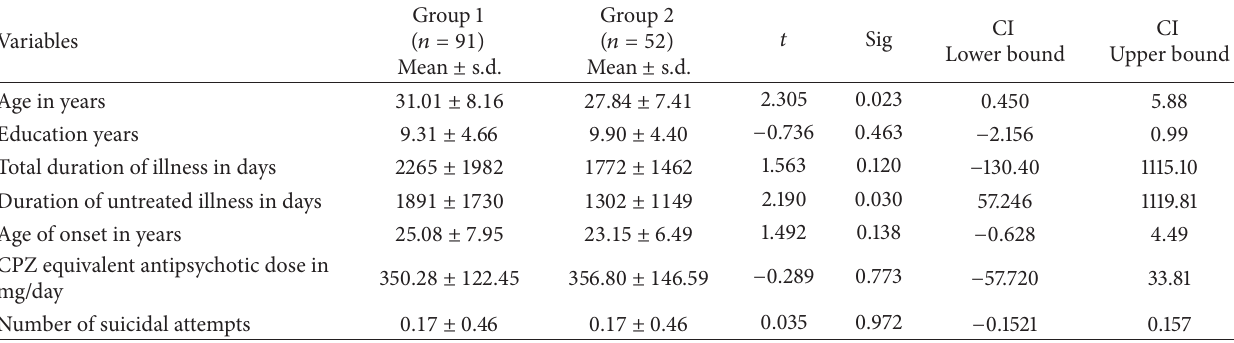
Table 1: Sociodemographic variables of schizophrenia patients with substance use disorder (Group 1) and without substance use disorder (Group